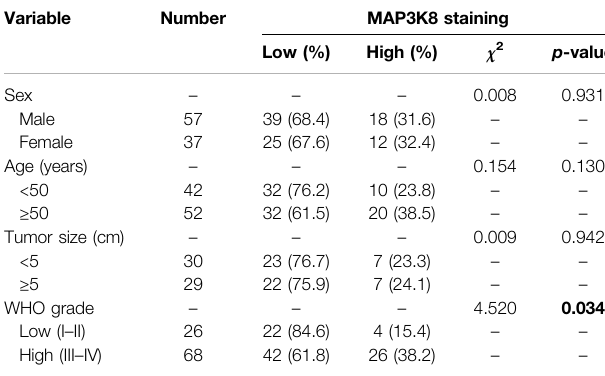
TABLE 2 | MAP3K8 immunohistochemistry (IHC) staining and clinicopathological characteristics of 96 glioma patients Variable Number MAP3K8